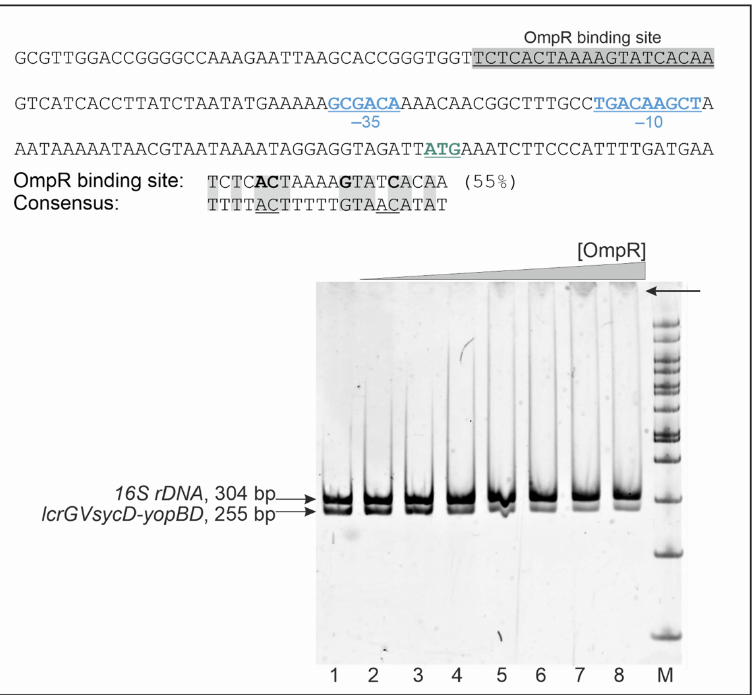
Figure 6. Binding of OmpR to the lcrGVsycD-yopBD operon promoter carrying a putative OmpR DNA-binding motif. The sequence of the promoter region of the lcrGVsycD-yopBD operon is presented in the upper panel with the − 35 and − 10 core promoter elements (blue, underlined) and the start codon (ATG, green underlined) indicated. The sequence shaded gray corresponds to the putative OmpR-binding site identified by in silico analysis. The percentage identity to the E. coli consensus OmpR-binding sequence is given. The lower panel shows an EMSA confirming the specific binding of OmpR-His 6 to a 255-bp DNA fragment containing the lcrGVsycD-yopBD promoter region. A 304-bp 16S rDNA fragment was used as a control for binding specificity and a competitor DNA. These DNA fragments were incubated with increasing amounts of His 6 -OmpR: 0.6 (lane 2), 1.2 (lane 3), 2.4 (lane 4), 4.8 (lane 5), 6.0 (lane 6), 7.8 (lane 7), 8.0 μ M (lane 8) or without protein (lane 1). Protein-DNA complexes were separated by electrophoresis on a 5% native polyacrylamide gel and detected by SYBR Green staining. An arrow indicates a shifted band containing the lcrGVsycD-yopBD promoter fragment. M-Nova DNA ladder 100 bp (Novazym). The DNA fragments were amplified with primers listed in Supplementary Table S1.